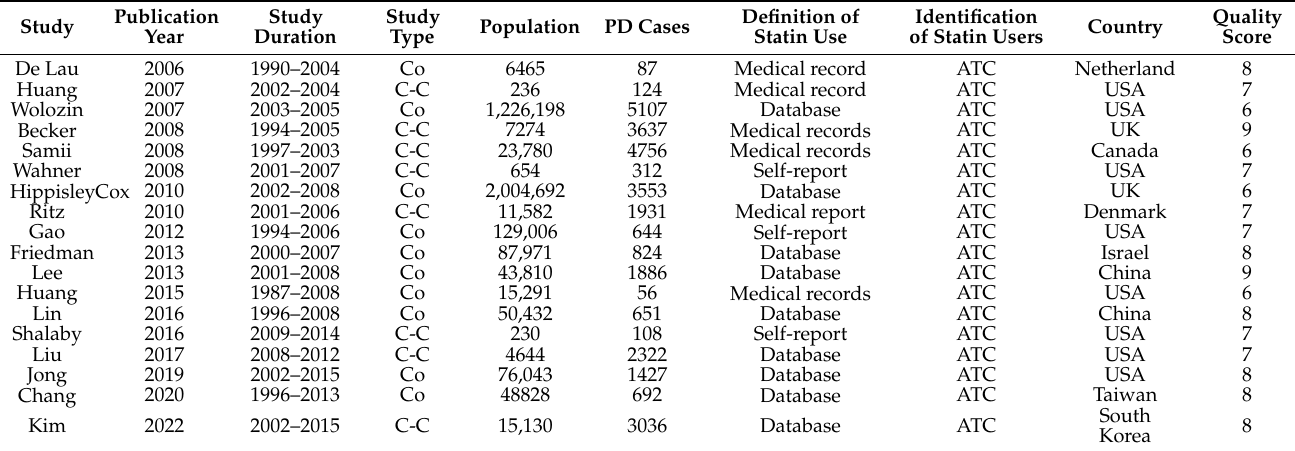
Table 1. Basic characteristics of included studies